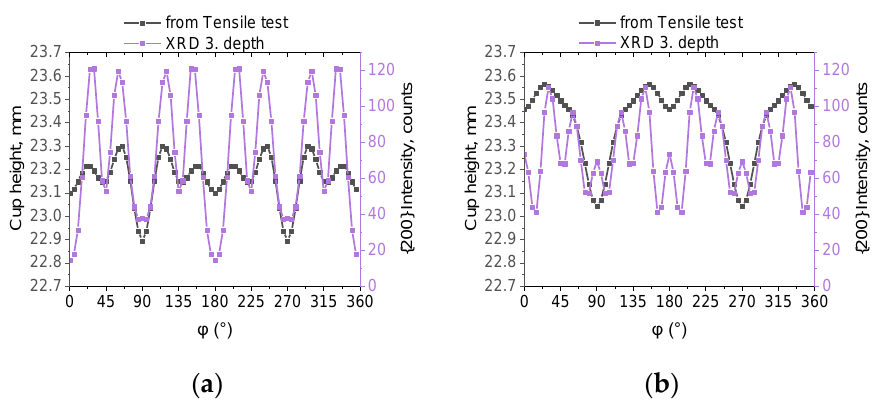
Figure 7. Earing profiles predicted from the Lankford values of tensile tests and from XRD texture measurements taken from different depths. ( a ) Sample from the side and ( b ) from the center of the hot-rolled sheet.